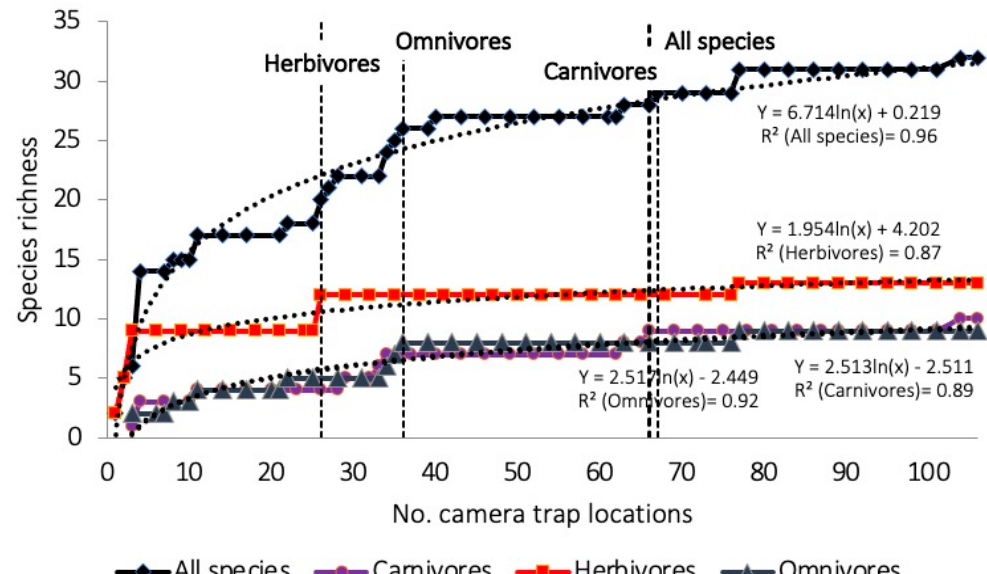
Figure 2. Species accumulation curves for large mammal taxa in Thung Yai Naresuan (East) Wildlife Sanctuary; vertical dash lines demonstrate the number of camera trap locations needed for 90% detection of all large mammal, carnivore, herbivore, and omnivore species.